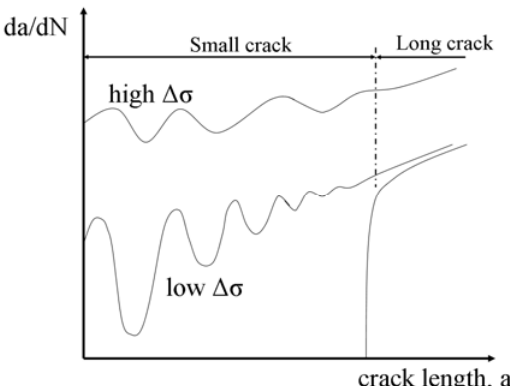
Figure 10: Typical evolution of crack growth rate as a function of crack length and stress amplitude. Adapted from